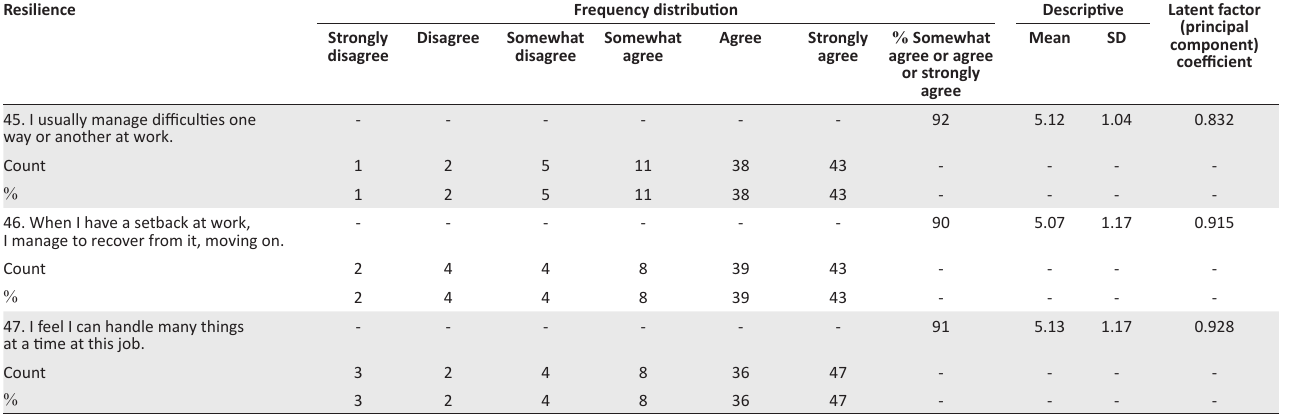
TABLE 13: Analysis of the construct of resilience.